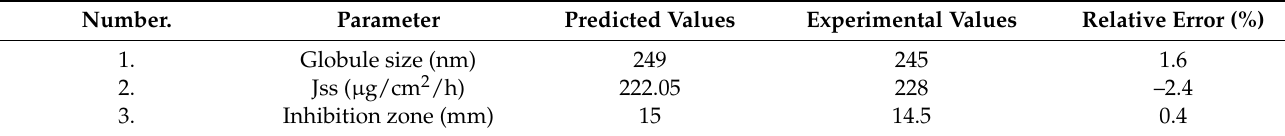
Table 8. Predicted versus experimental values for selected responses.